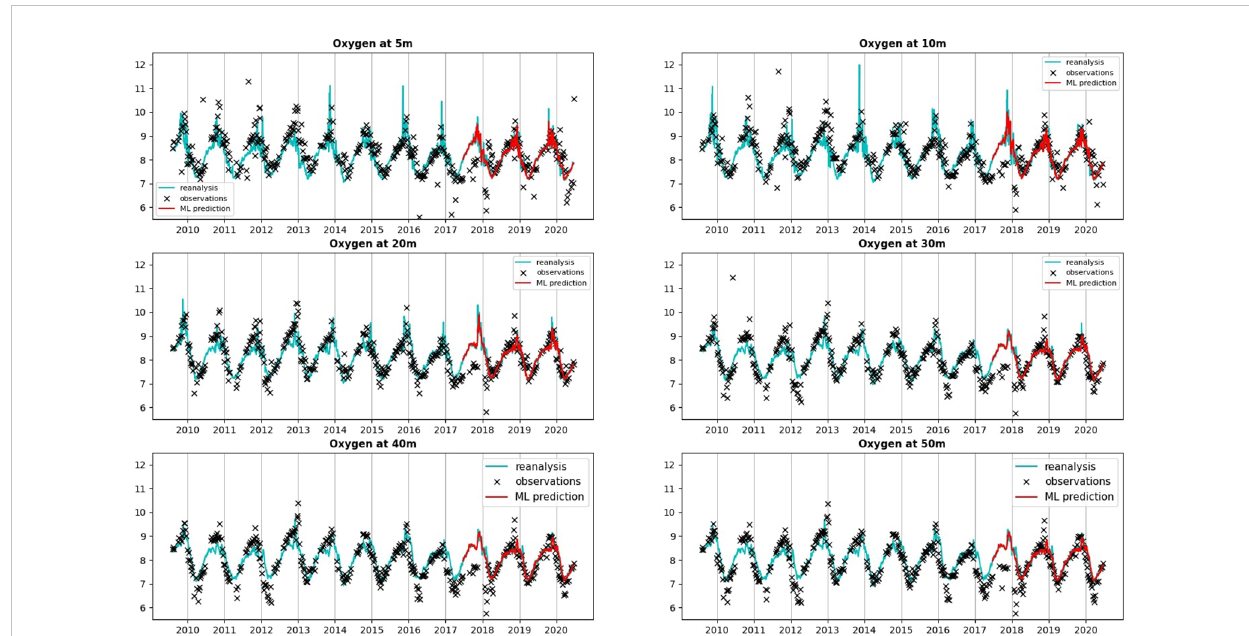
FIGURE 3 Comparing the oxygen total (climatology+anomaly) concentrations (in mg/L) at L4 between the reanalysis providing the training/validation/test data and the L4 observations. For completeness we show also the values predicted by a ML model (multilayer perceptron neural network) for the last 3 years of the time-series (2018-2020), which correspond to the test data. The ML model however predicted only the oxygen anomalies, which were added here to the L4 oxygen daily climatology known from the Met Of fi ce reanalysis. The oxygen concentrations are compared at a range of depths, excluding the surface values, since at the surface the L4 observations were largely missing. To show the limited oxygen range on the y-axes of the different panels, few observational outliers have been